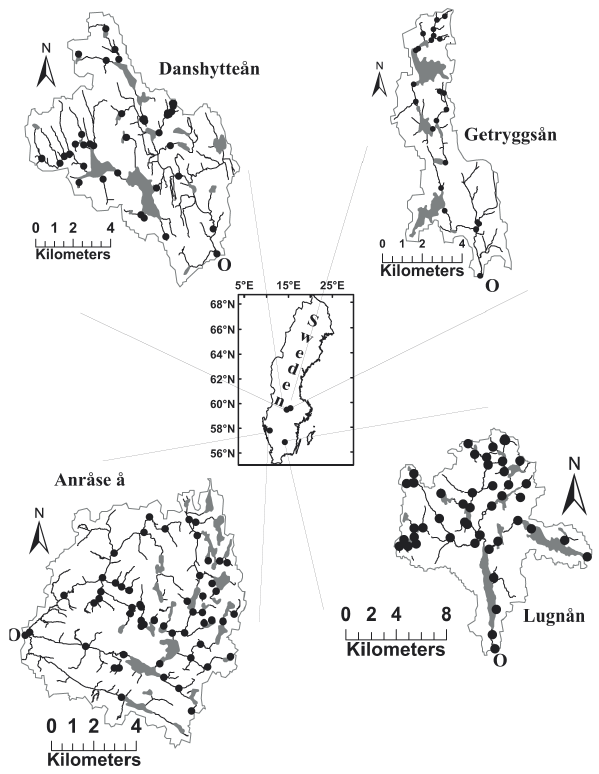
Fig. 1. Map of Sweden with the four rivers included: Danshytte˚an (R. D.), Getryggs˚an (R. G.), Anr˚ase ˚a (R. A.) and Lugn˚an (R. L.). The black dots are sampled sites. For stream junctions one dot could indicate that samples were taken upstream and downstream of the junction. O indicates the outlets of the